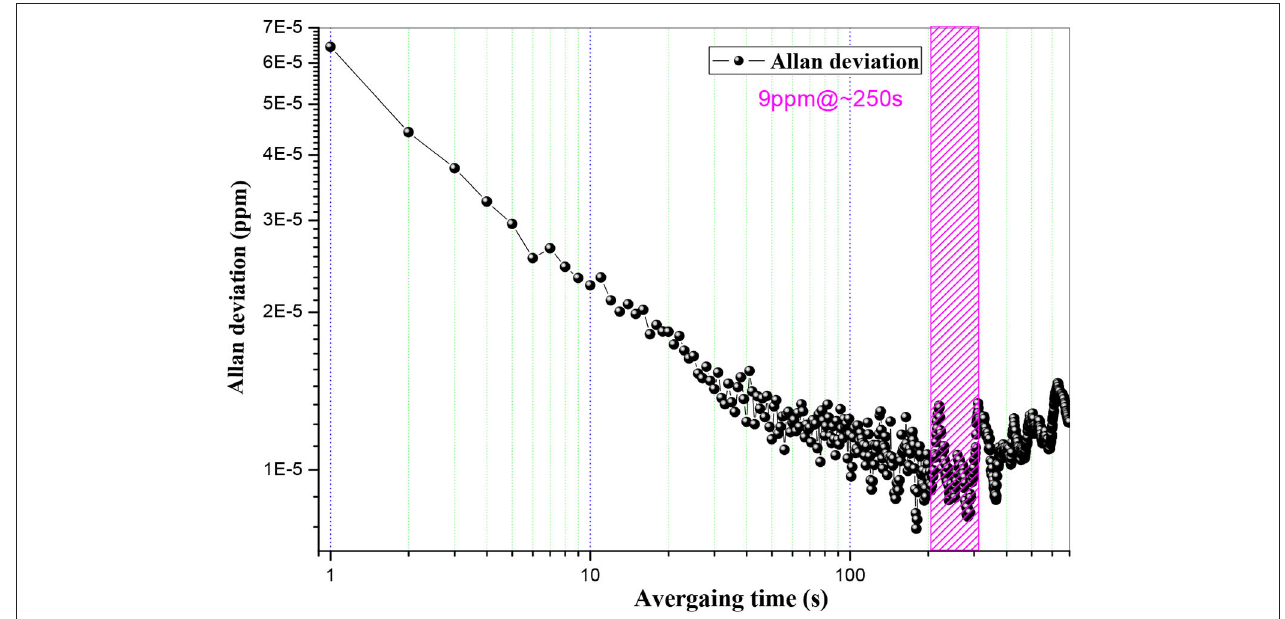
FIGURE 7 | Allan deviation plot as a function of signal average time.